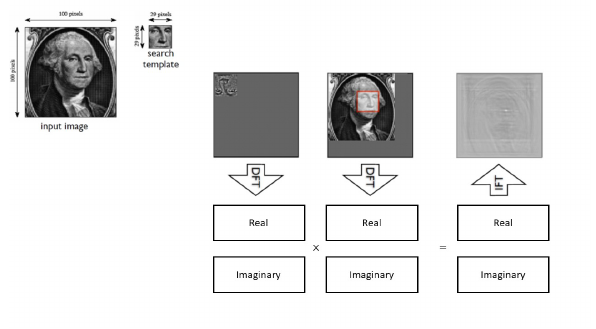
Figure 9. FFT image matching.